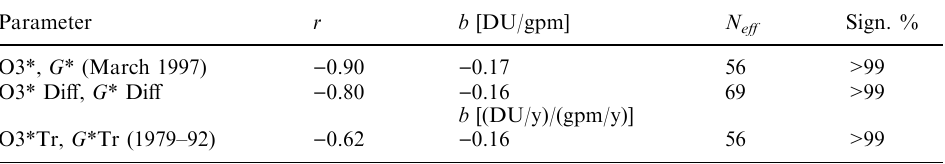
Parameter r b [DU/gpm] N